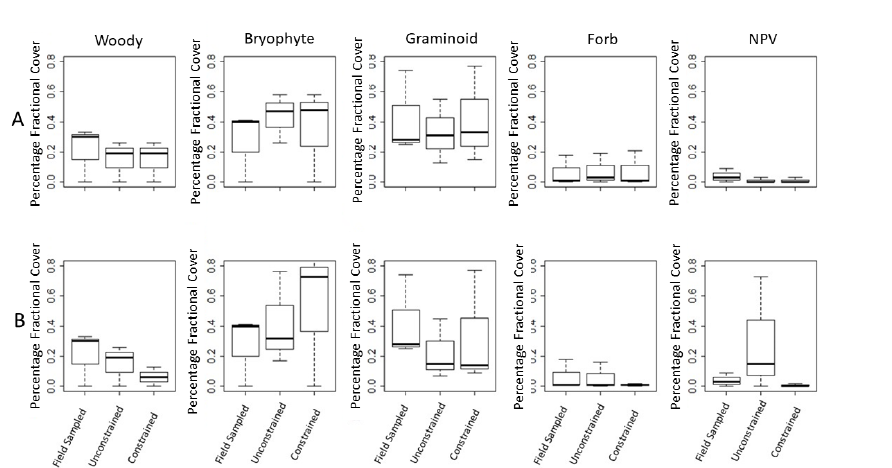
Figure 7. Boxplot results provide a visualization of the difference in means between the field sampled plots’ fractional coverage of PFT, and that of the PFT coverage as described by the spectra of G-LiHT in sampled pixels and the pixels of the small swaths surrounding the sampling transects; results are shown for the two libraries: ( A ) 4-band and ( B ) 110-band.